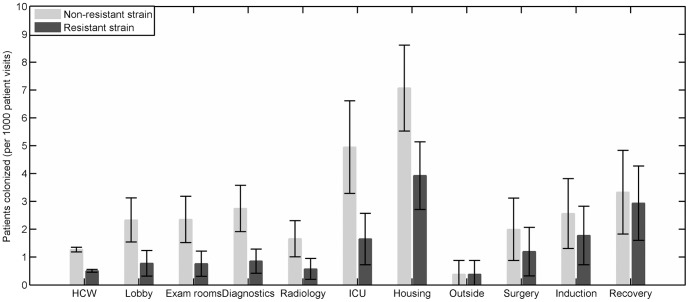
Proportion of visiting patients colonized.The average proportion of patients in contact with the healthcare workers (HCW) and the various transmission points that become colonized with non-resistant (N) and resistant (R) strains over the length of a year averaged over 500 simulations. Bars represent standard deviation across the yearly averages of 500 simulations.